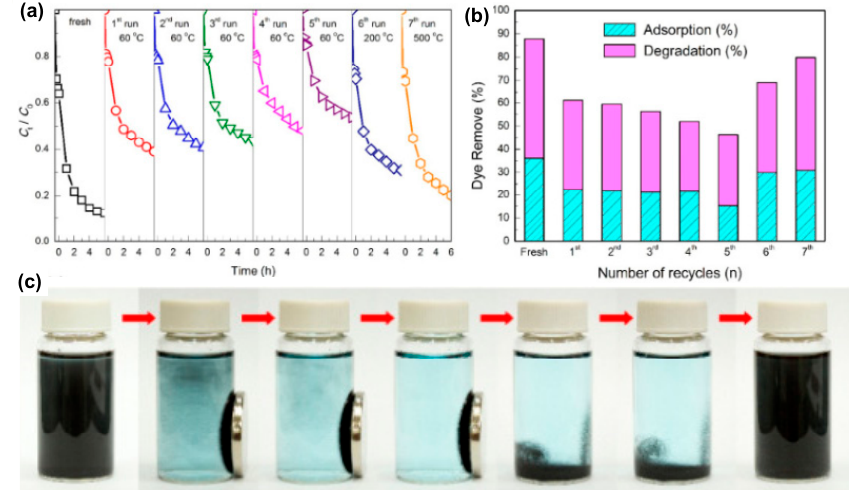
Figure 17. ( a ) The cycling test of the catalytic performance. ( b ) Dye removal capacity by adsorption and degradation for different cycles. ( c ) Digital photos demonstrating the recyclability by using an external magnetic field. Adapted with permission from Reference [92]. Copyright (2017) Elsevier.